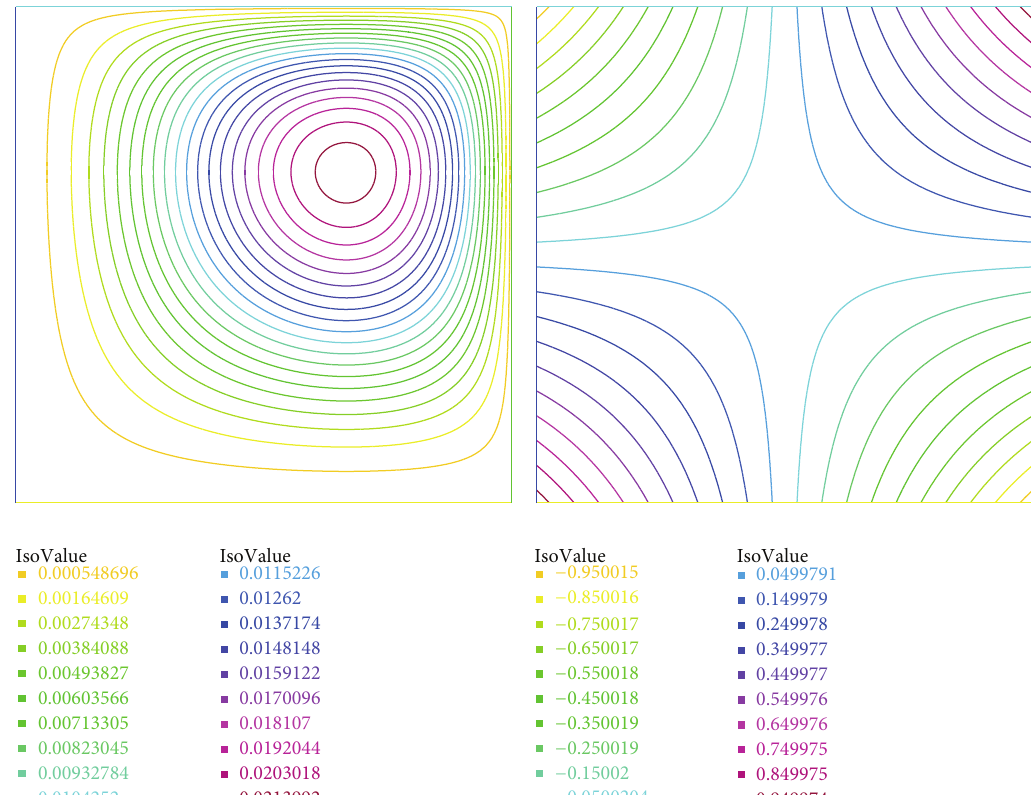
Figure 4: Streamline of flow and pressure contour by Oseen method.